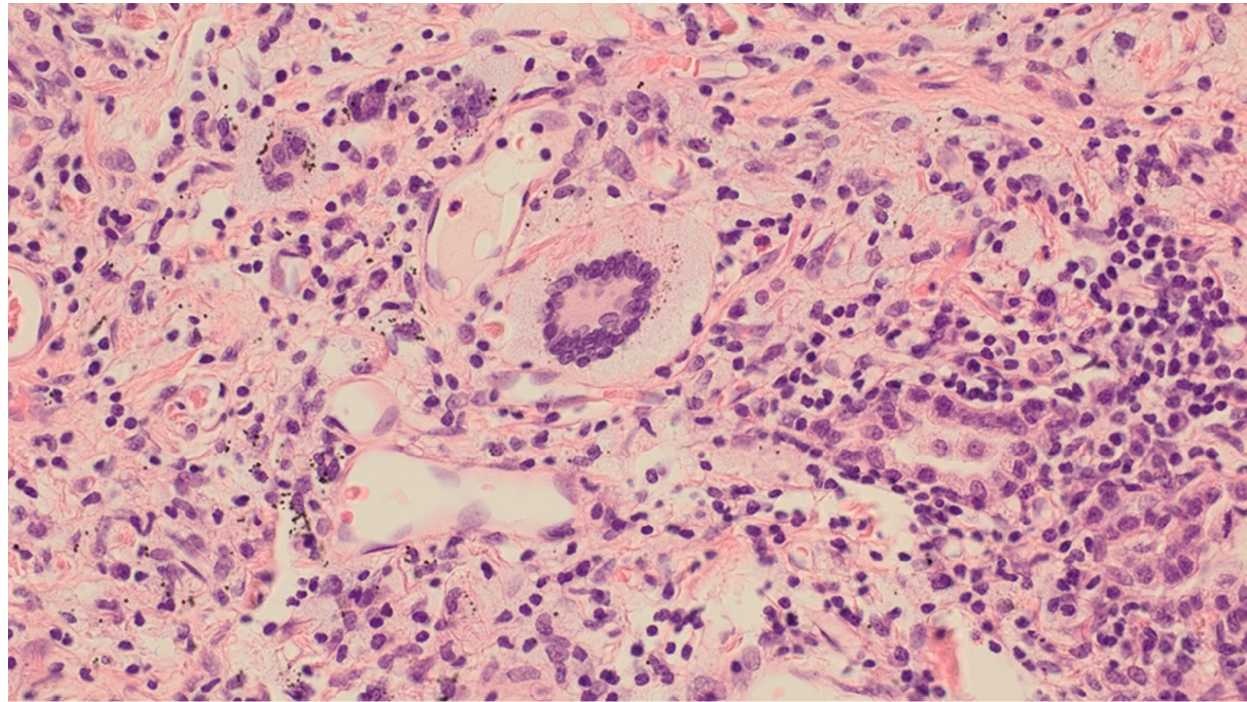
Figure 4. Video-Assisted Thoracoscopic Surgery (VATS) biopsy from the right lung’s middle lobe: Granulomatosis with Polyangiitis (GPA) with a multicore giant cell: a characteristic multinucleated giant cell with smudged basophilic nuclei marginated at the periphery of the cell. Magnification: ×40. Haematoxylin and Eosin (HE) stain.